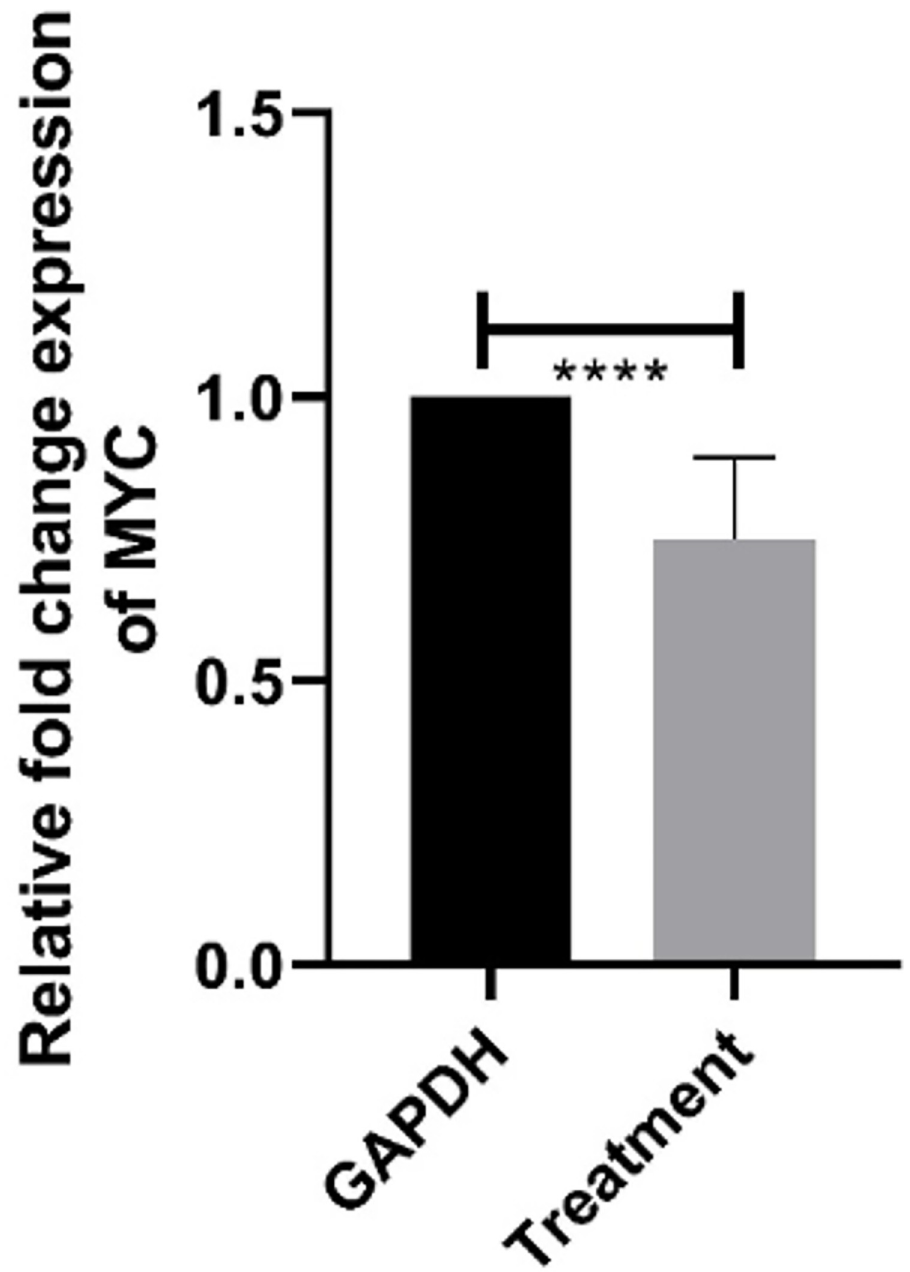
Fig 7. Relative expression analysis of MYC gene. Relative fold change in expression of Huh7 cell lines treated with methanol extract of leaf of Artemisia absinthium . Bars are expressed as Mean ± SEM and **** , represents significant differences at P <